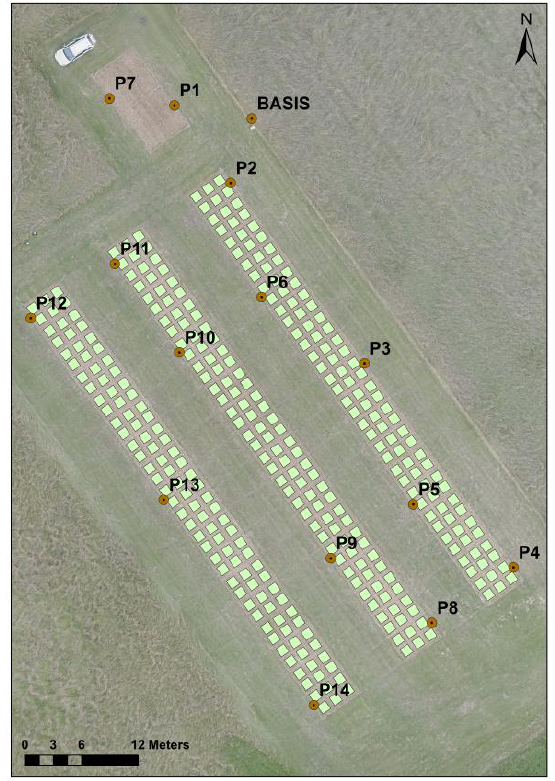
Figure 2. Composite photo of basis date (9 th June 2015) with polygons and